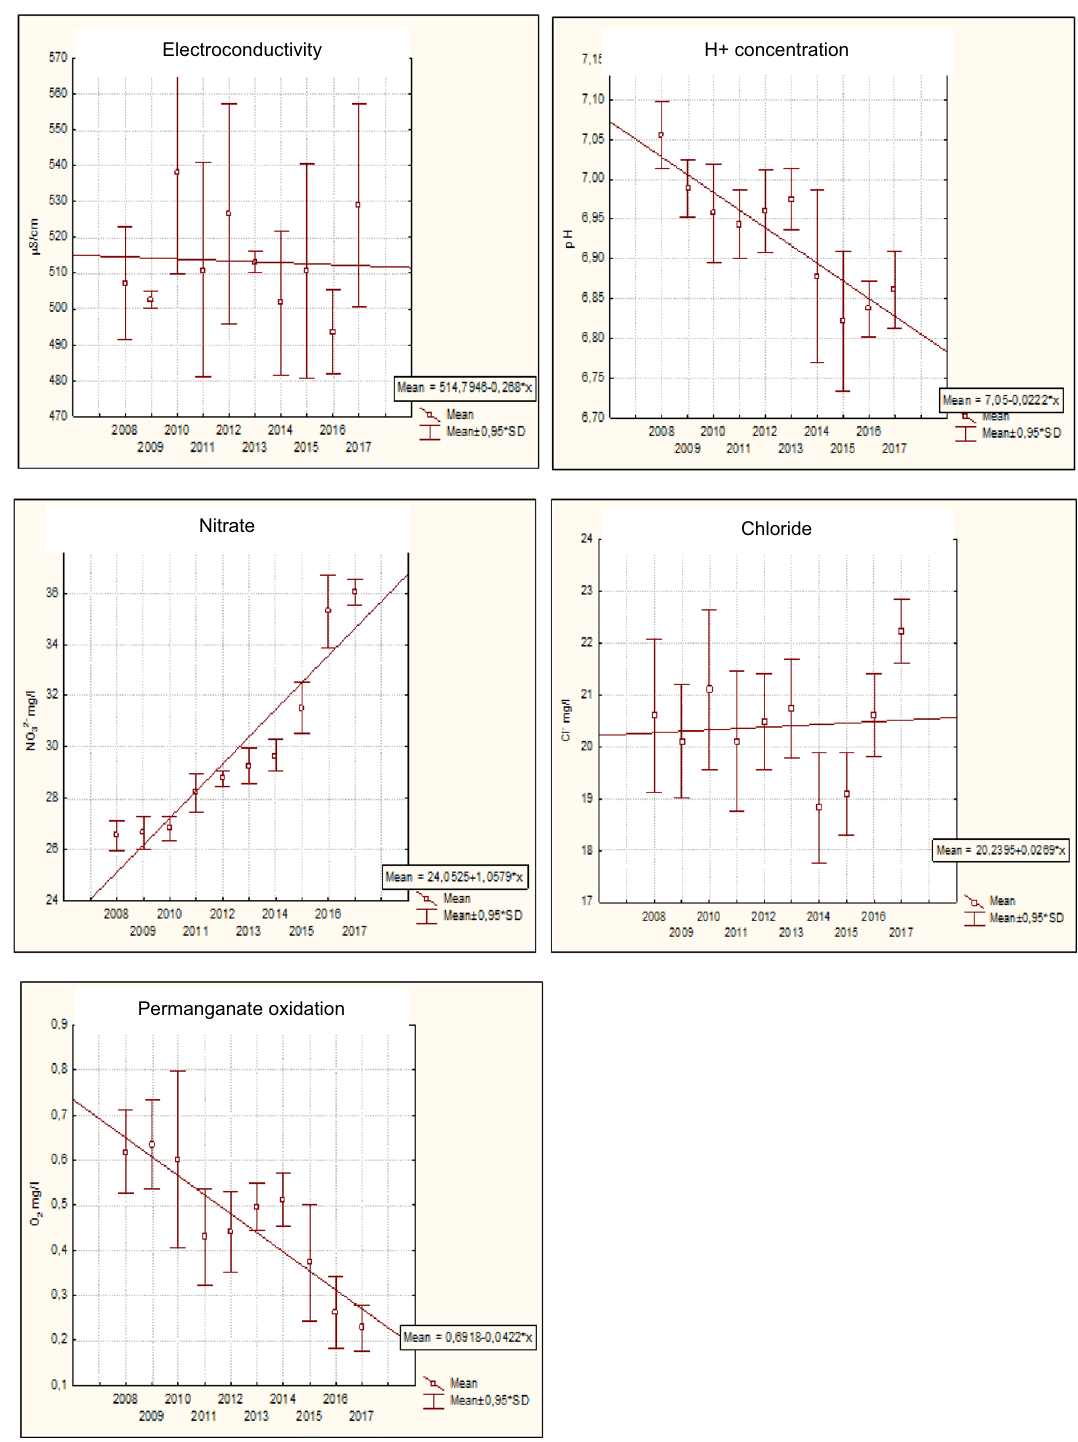
Fig. 4 Concentrations and linear trends for physicochemical parameters (electroconductivity, H. + concentration, nitrate, chloride, permanganate oxidation) in groundwaters from the Ivanščak well field (mean, median, Q1-Q3 box, min–max